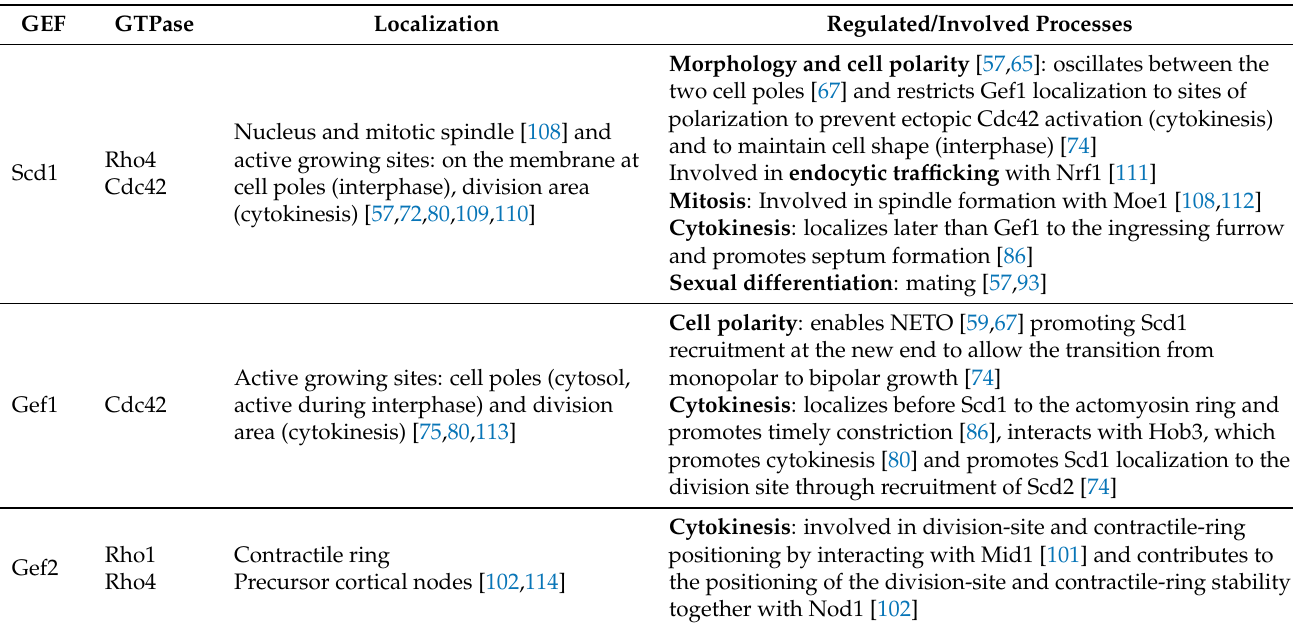
Table 2. Guanine nucleotide exchange factors (GEFs) for Rho GTPases in fission